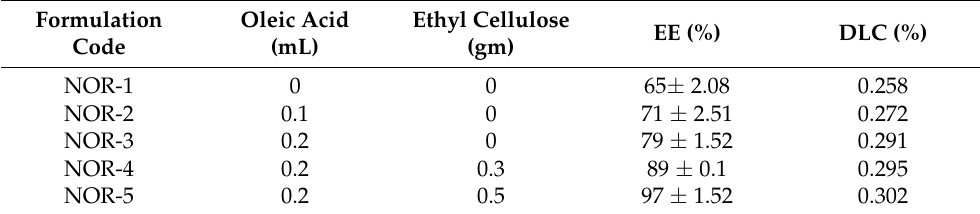
Table 4. Impact of helper lipid and polymer on EE % and DLC